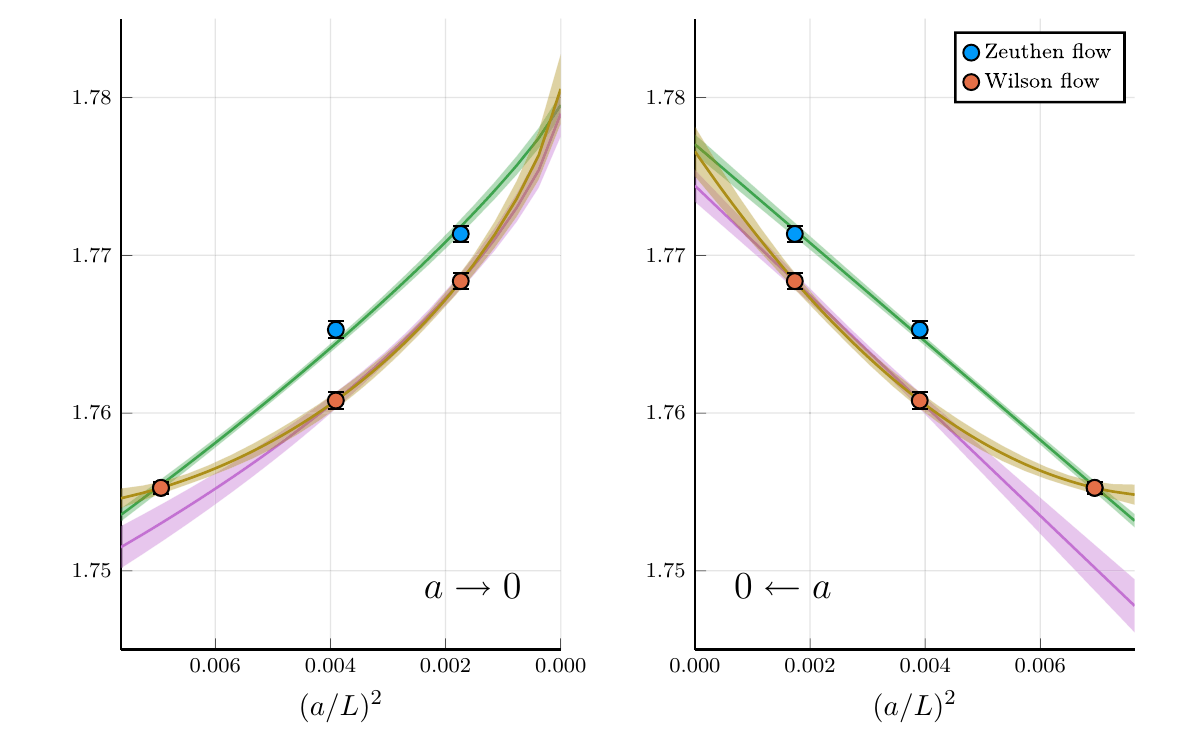
√ Fig. 6 Continuum extrapolation of (cid:6) c = 0 . 2 ( u , a / in the functional ansatze. For the case of the Zeuthen flow we use 8 t ) for u = 1 . 5. p 0 + p 1 ( a / L ) 2 log ( a / L ) , while for the case of the Wilson flow, we Right: extrapolations of the Zeuthen flow data with a functional form of the type p 0 + p 1 ( a / L ) 2 . For the case of the Wilson flow one use functional forms p 0 + p 1 ( a / L ) 2 log 2 ( a / L ) and a three parameter can extend the fitting range by including a quadratic term in the ansatze p 0 + p 1 ( a / L ) 2 log 2 ( a / L ) + ( a / L ) 4 that allows to extend the extrapolation O ( a 4 ) . The extrapolated values show a reasonable agree- fitting range. Summary: the extrapolated values vary significantly with the choice of logarithmic terms ment. Left: the same data is extrapolated including logarithmic terms